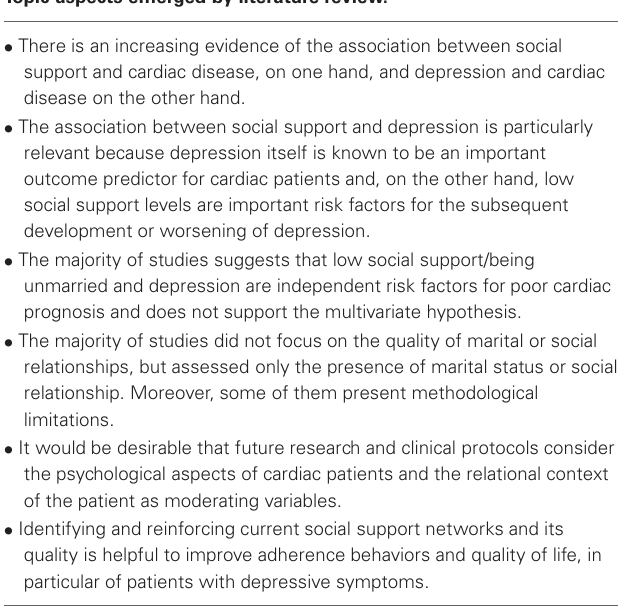
Table 2 | Topic aspects emerged by literature